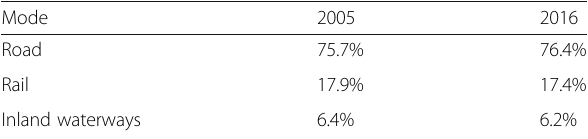
Table 1 Modal split (% based on ton-kilometres) in EU28, adjusted for